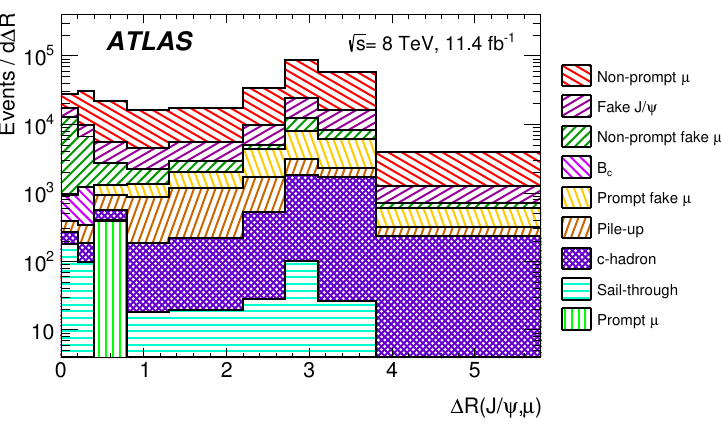
Figure 4 . Breakdown of the contributions from the signal and di(cid:11)erent sources of background across the distribution of (cid:1) R ( J= ; (cid:22)